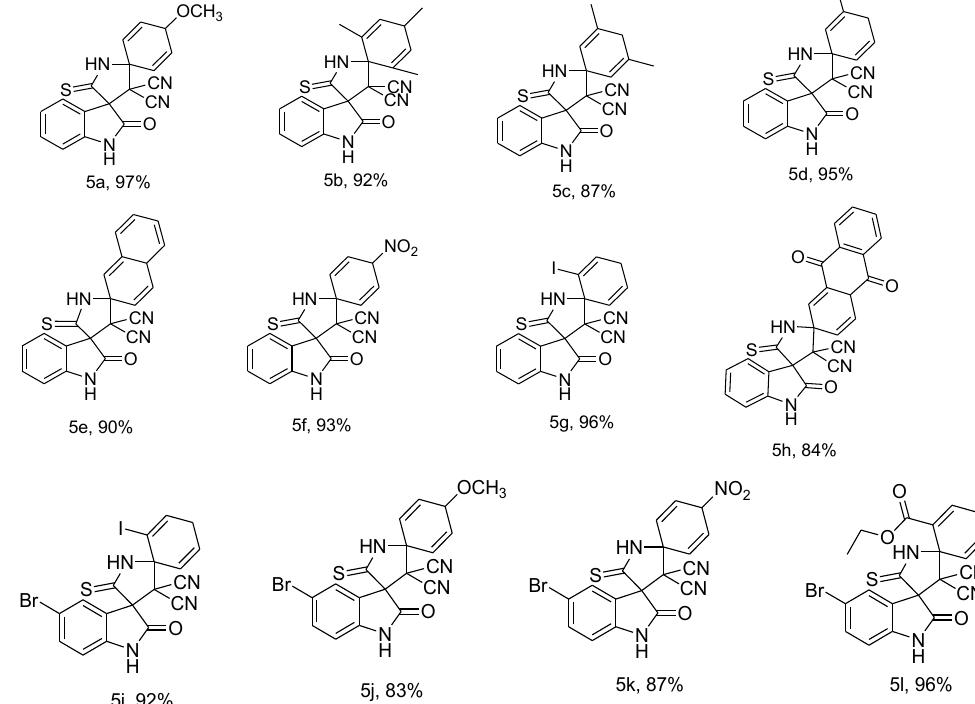
Figure 5. Variation of isothiocyanate moieties in the synthesis of spiroindole pyrrolidine under aqua condition.